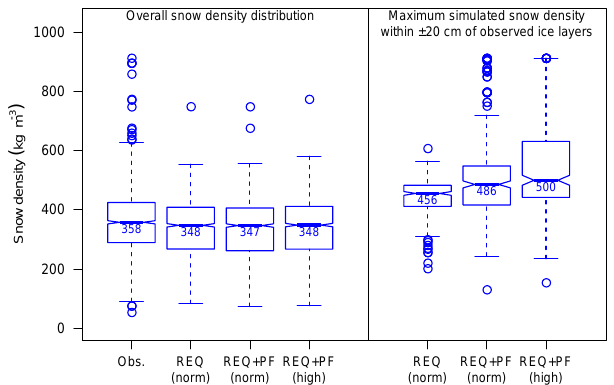
Figure 7. Box and whisker plot showing the distribution of snow density from observations (obs), simulations with the Richards equation (REQ) and simulations with the dual domain approach to describe preferential flow (REQ + PF). On the left, simulated snow density represents an aggregated snow density over multiple model layers to match the measured layer thickness. On the right, snow density of an individual model layer is shown. Boxes represent in- terquartile ranges (25th to 75th percentiles), and thick horizontal bars in each box denote the median (50th percentile), the value of which is shown directly below the bar. Whiskers (vertical lines and thin horizontal bars) represent the highest and lowest value within 1 . 5 times the interquartile range above the upper or below the lower quartile, respectively. Notches are drawn at ± 1.58 times the in- terquartile range divided by the square root of the number of data points. Outliers are shown as individual dots.